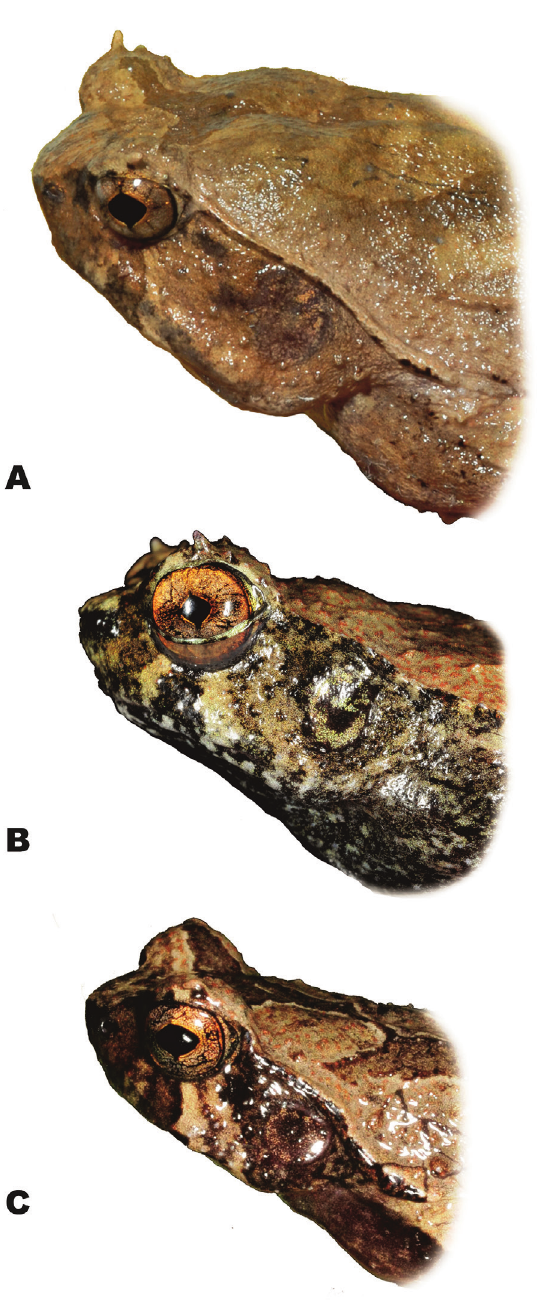
Figure 13. Comparison of the head coloration in life of three Ophryophryne species from the Langbian Plateau: A Ophryophryne synoria , Bu Gia Map N.P., Binh Phuoc Prov., Vietnam B Ophryophryne gerti , Chu Yang Sin N.P., Dak Lak Prov., Vietnam C Ophryophryne elfina sp. n., Hon Giao Mt., Bidoup–Nui Ba N.P., Lam Dong Prov. Photos by N.A. Poyarkov and N.L.